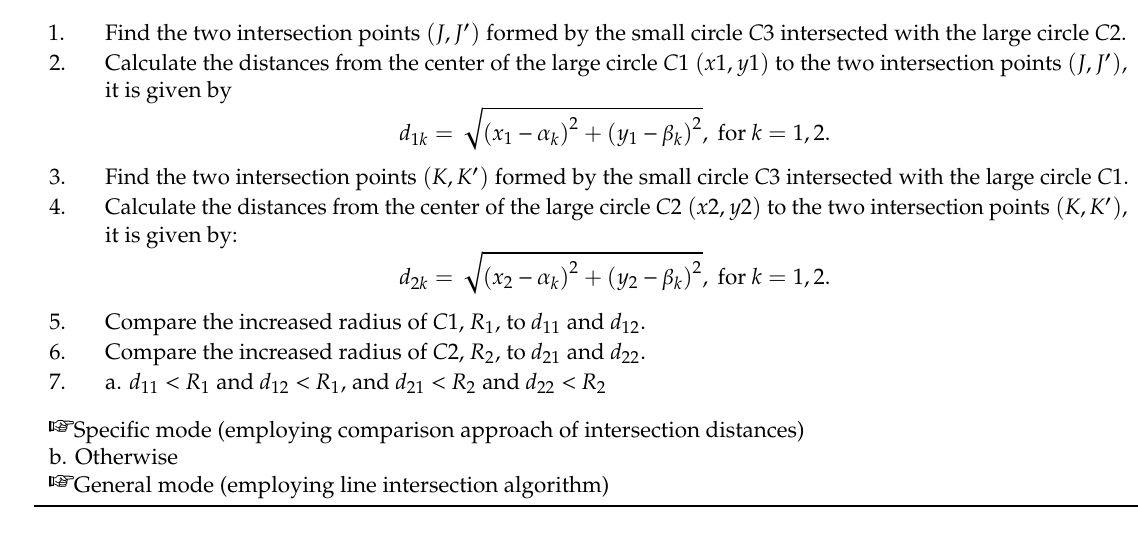
Table 3. Mode Selection